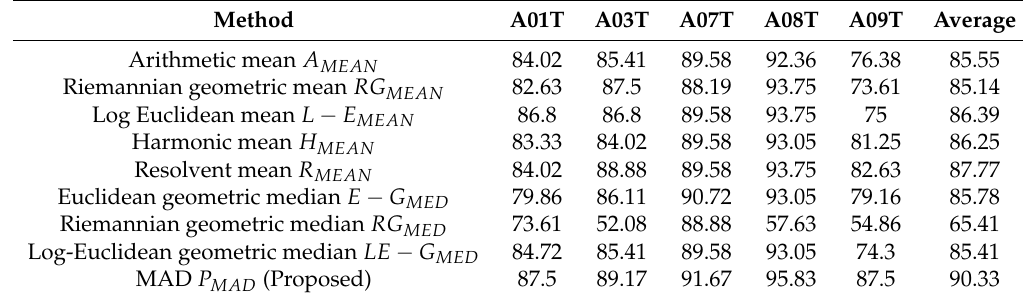
Table 4. The classification accuracy (%) of TSMLDA for BCI IV-IIa.